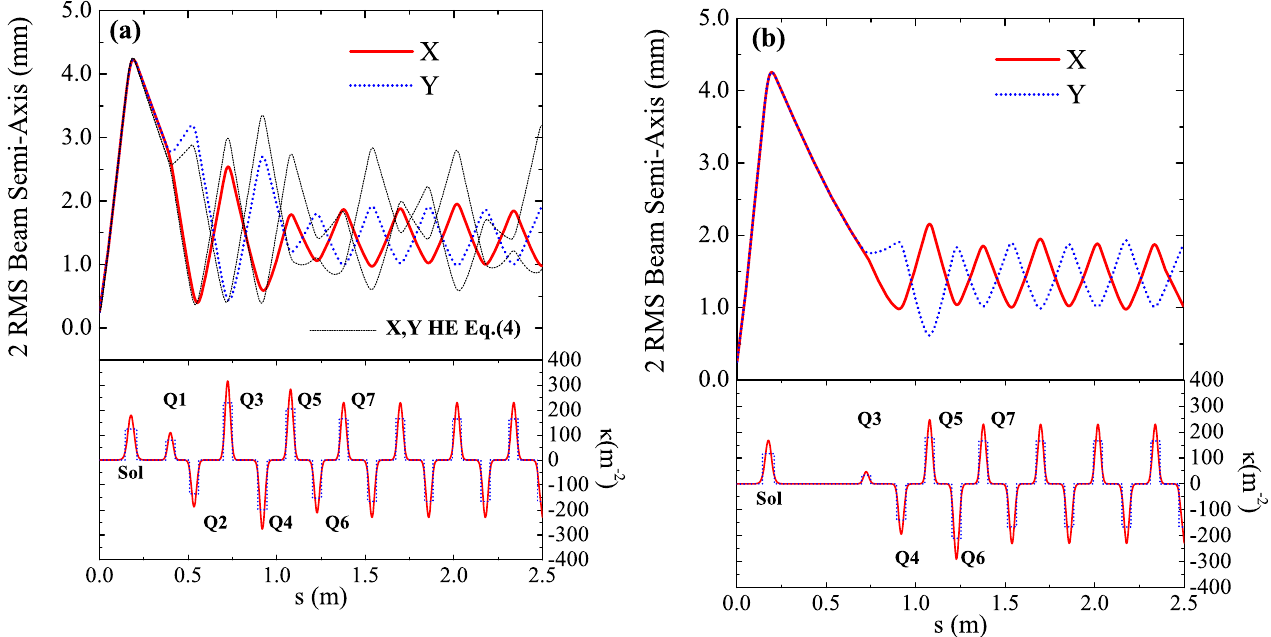
FIG. 10. (Color) Two solutions for UMER RMS-envelope matching with a short solenoid and a number of PC quadrupoles (see also Table V). Electron beam parameters are: 0.55 mA, 10 keV, and (cid:4) (cid:5) 6 : 0 (cid:10) m . One transverse component of the focusing function is shown at the bottom in each case, including the equivalent hard-edge function. (a) Solution employing all six PC quadrupoles, and (b) solution with four PC quadrupoles (Q1 and Q2 are off). In (a), the envelopes that result from a simple hard-edge model (not the one at the bottom) are also